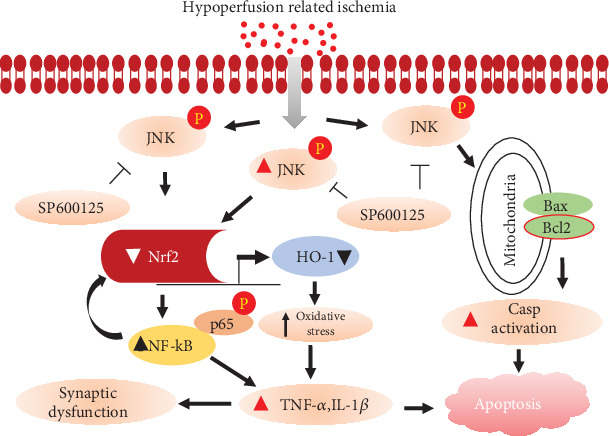
Indicating the diagrammatic abstract.